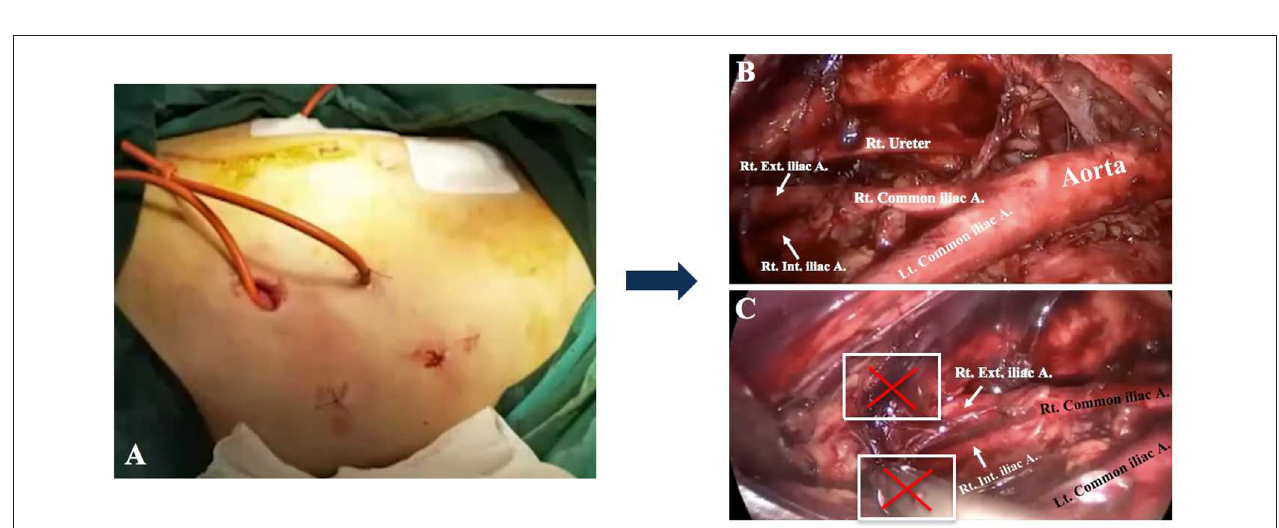
FIGURE 2 | The lateral extraperitoneal approach for lymphadenectomy. (A) The lateral incisions. (B) Para-aortic LN dissection. Bilateral obturator fossae were challenging to reach when performing pelvic lymphadenectomy (C) .